Question: What style of plot is this figure drawn as?
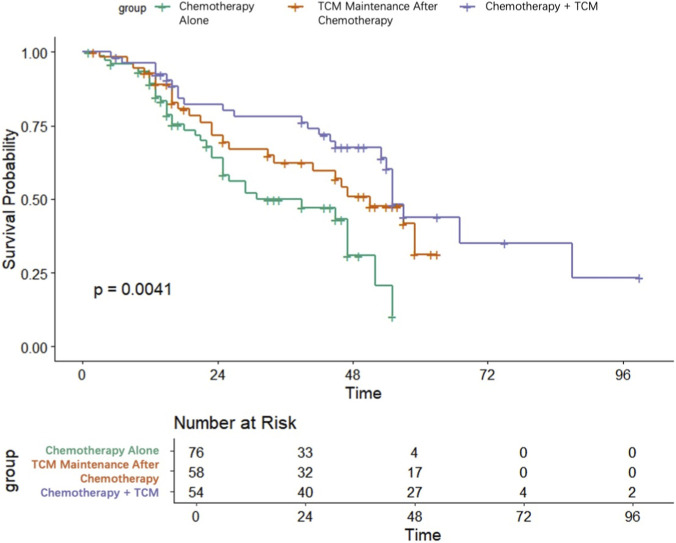
Answer: survival